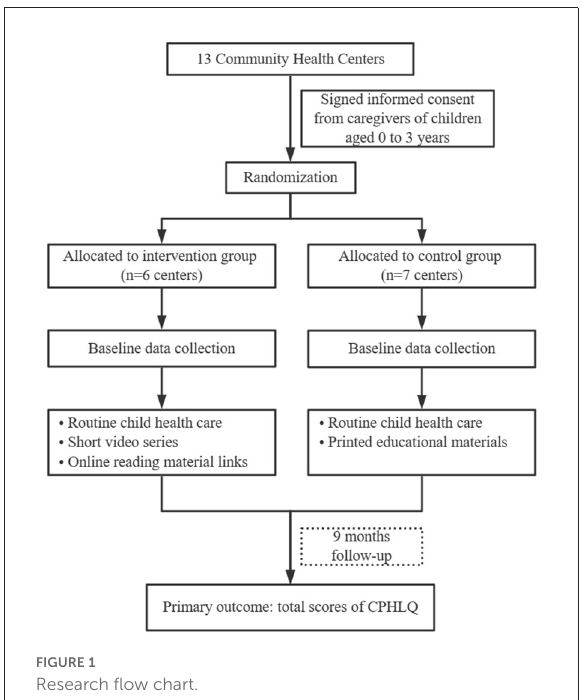
FIGURE1 Research flow